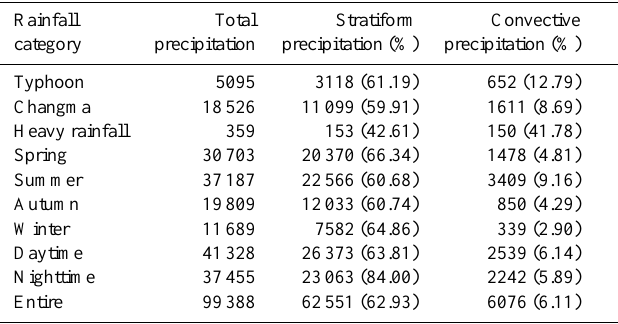
Table 3. Rainfall rate for each rainfall category and the number of sample sizes for 1min